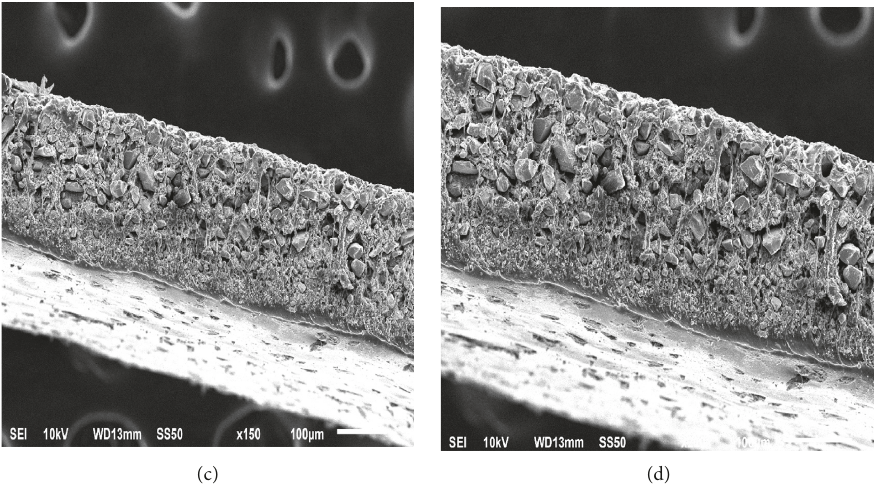
Figure 11: SEM microphotographs of PANI/PVC-PEDOT: PSS-ZrP. (a) Image at a magnification of 500 × before actuation. (b) Image at a magnification of 500 × after actuation. (c) Cross-sectional image at a magnification of 150 × before actuation. (d) Cross-sectional image at a magnification of 150 × after